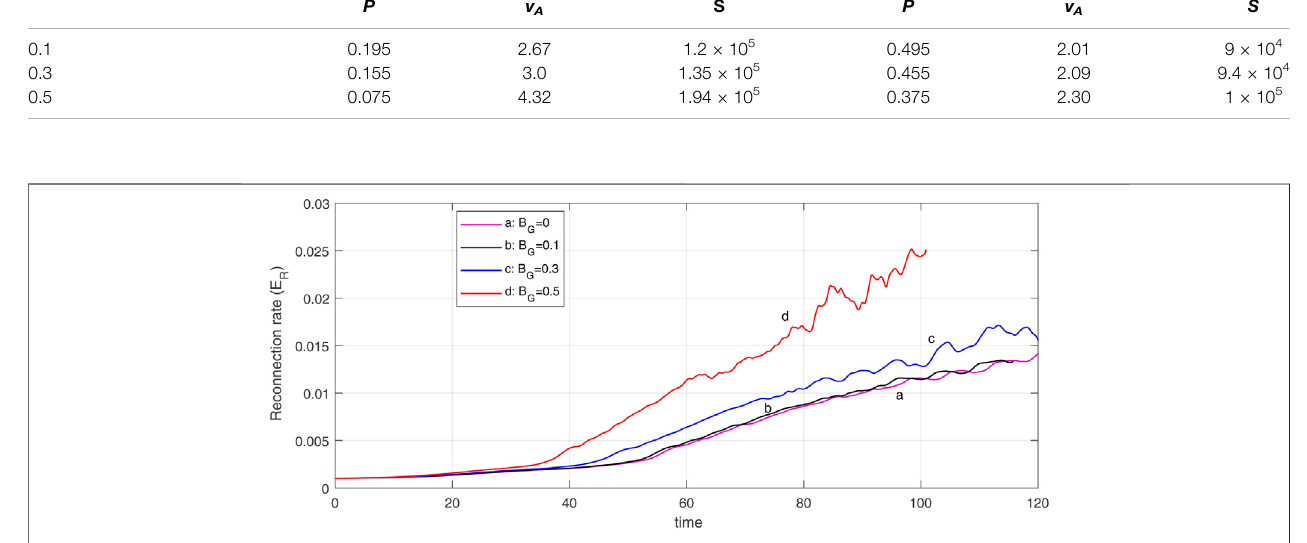
TABLE 2 | Dependence of the physical parameters on the uniform guide fi eld for β (cid:1) 0.4 and β (cid:1) 1.0 B g (uniform guide fi eld) β = 0.4 β = 1.0